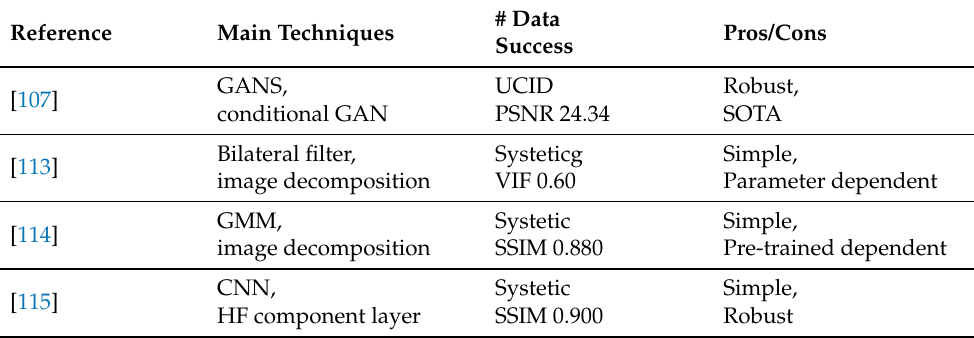
Table 11. Performance evaluation of the reviewed image de-raining